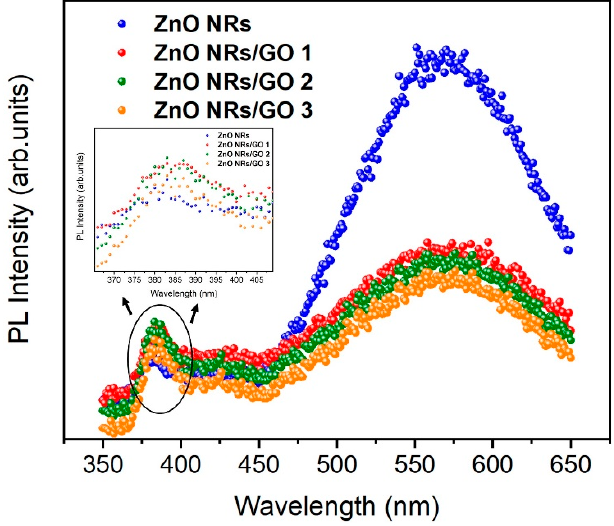
Figure 10. Photoluminescence (PL) spectra of ZnO NRs and ZnO NRs/GO nanocomposites (inset shows room temperature PL spectra in the ultraviolet (UV) region of ZnO NRs and ZnO NRs/GO nanocomposites).